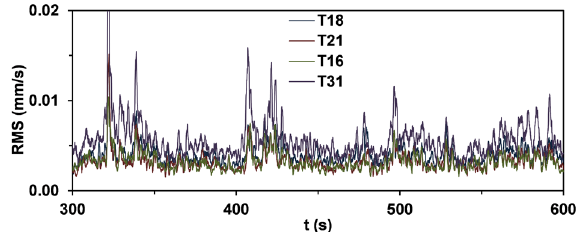
Figure 26. RMSs in tangential directions at T18, T2, T16 and